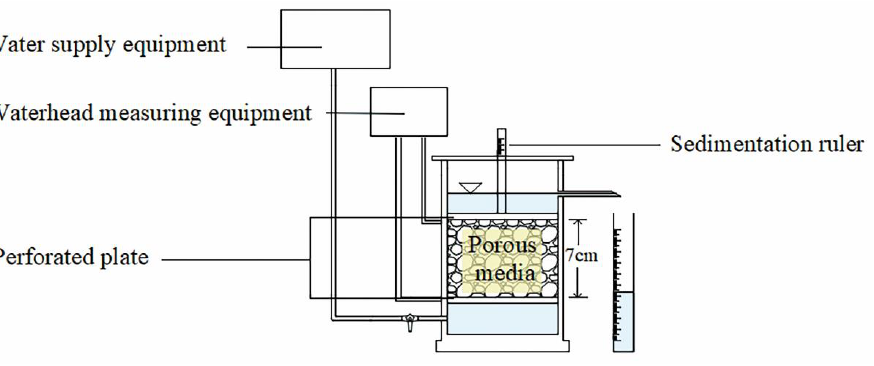
Figure 3. Constant-head permeability test